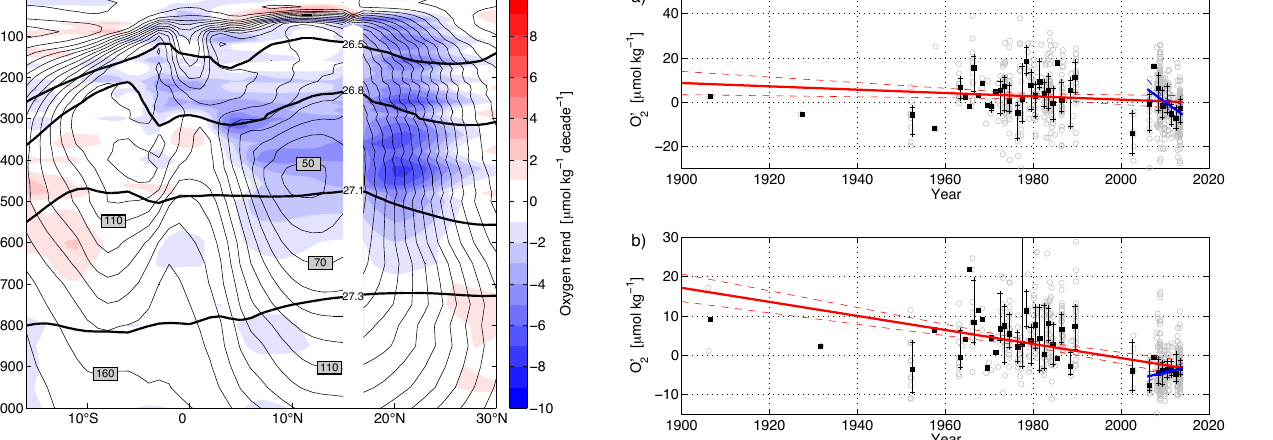
Figure 19. Oxygen anomalies for the region 9–15 ◦ N, 20–26 ◦ W and 150–300m (intermediate oxygen maximum, upper panel) and 350–700m (deep oxygen minimum, lower panel). Grey circles rep- resent all available data, whiskers show interquartile range of data within each year and the black squares annual medians. Trends are calculated using annual medians weighted by the square root of available data within each year for the period 1900–2013 (solid red line) and 2006–2013 (solid blue line). The dashed lines mark the standard errors of the